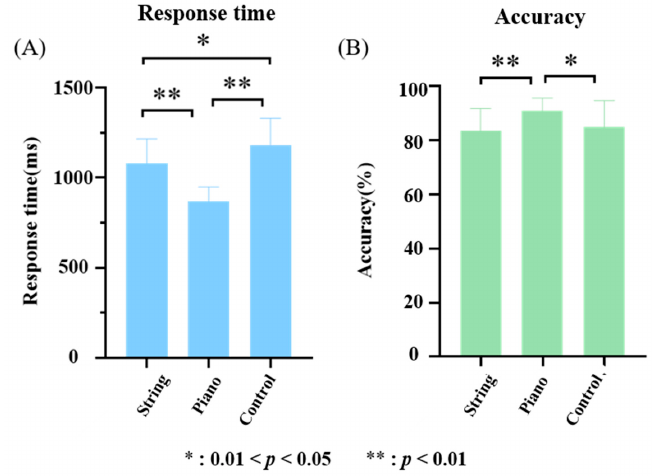
Figure 3. response time and accuracy ( A ) Differences in response time between string musicians Figure 3. Response time and accuracy ( A ) Differences in response time between string (showed as String in the figure), pianists (showed as Piano in the figure), and the control group